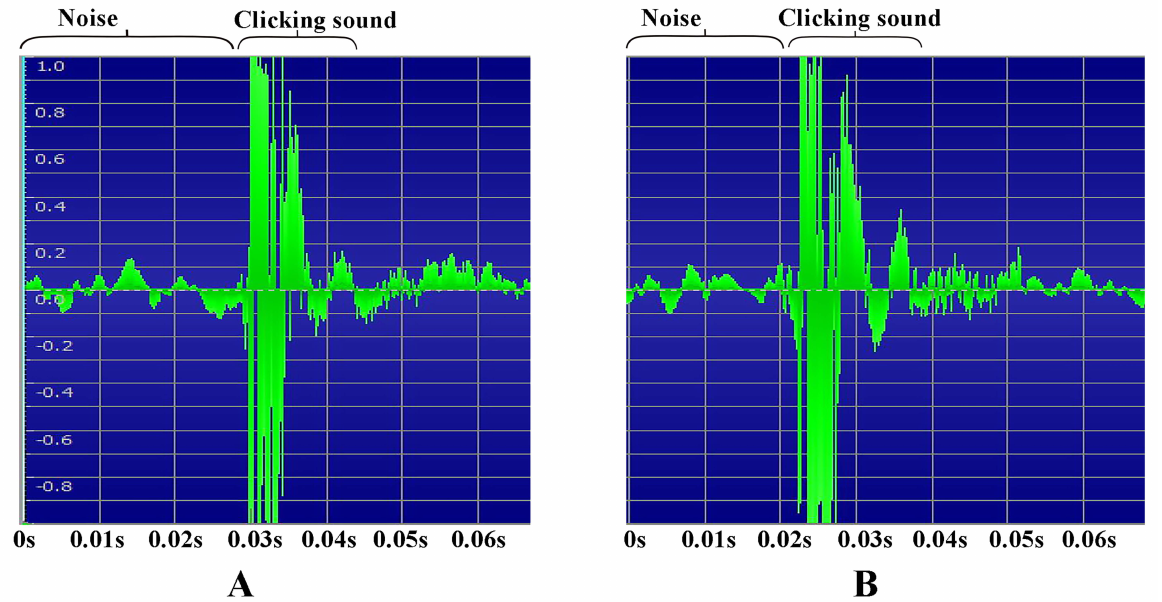
Figure 14. The oscillograms of the clicking sound of Campsosternus auratus . ( A , B ) show two clicking sounds of an individual; the oscillogram photograph was generated using GOLDWAVE software. ( A ) The clicking sounds last approximately 0.007 s; the frequency is approximately 250 HZ. ( B ) The clicking sound lasts approximately 0.015 s; the frequency is approximately 200